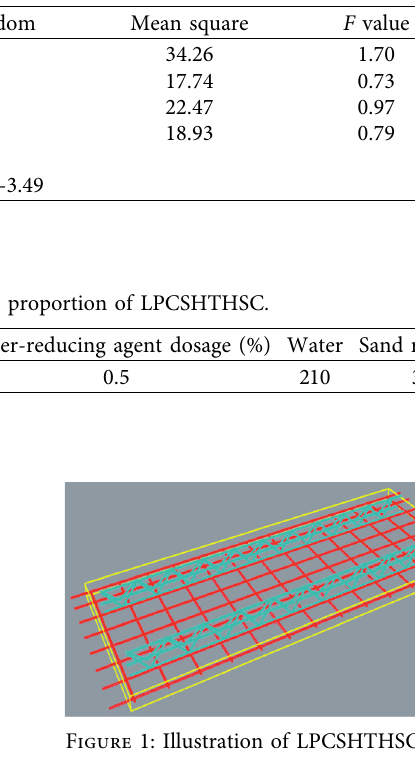
Table 8: Variance analysis of 28-day compressive strength of concrete.